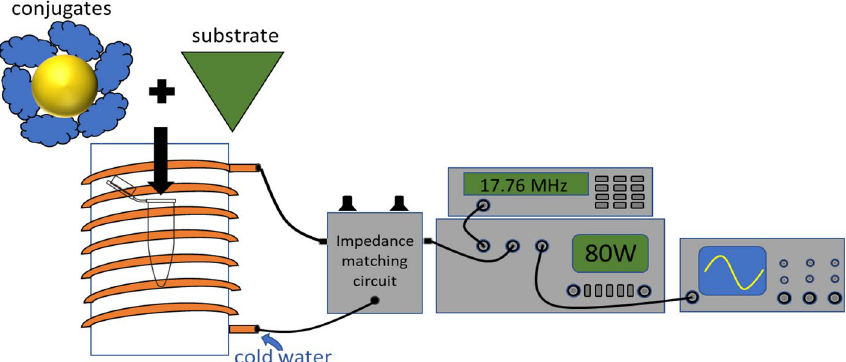
Figure 1. Illustration of radiofrequency heating system. A function generator is used to create a sinusoidal 17.76 MHz signal which is sent to a power amplifier. The signal is then sent through an impedance matching circuit and into the water cooled solenoid. For full details see SI page